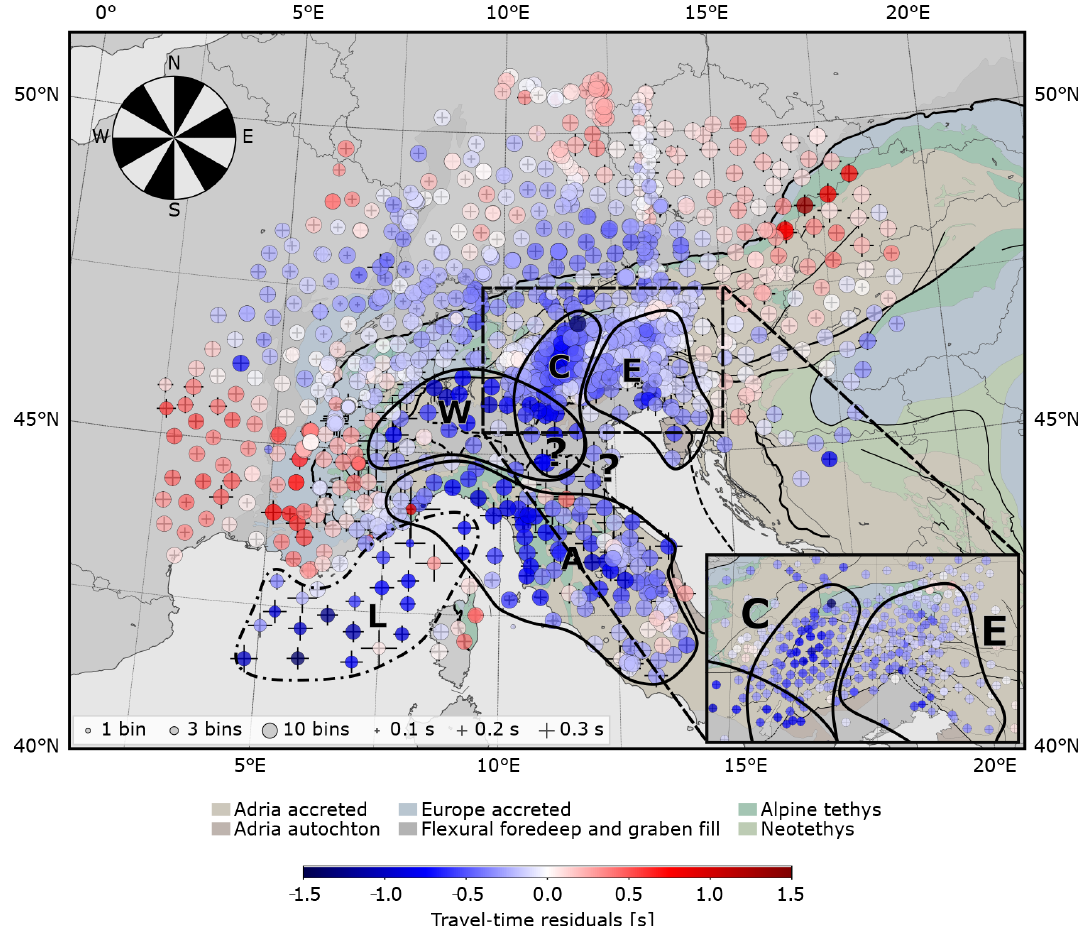
Figure 10. Stacked travel-time differences for 370 events of the high-frequency dataset db 0 . 5 corrected for crustal influences. Circle sizes correlate with number of back-azimuth bins for each station (maximum = 12). Blue colours point to subsurface structures with v p values higher than average, red colours to structures with v p values lower than average. Travel times are binned calculating the mean travel time for all events within 30 ◦ bins to balance out directional influences. Standard deviation of the azimuthal influence on each station is marked by crosses; e.g. small crosses mark stations residuals mostly independent of variations in back-azimuth. A travel-time correction is applied for the station elevation using a constant near-surface velocity estimate of 5.5kms − 1 . High-velocity anomalies are contoured as follows: W – western Alps, C – central Alps, E – eastern Alps, A – Apennines, L – Ligurian Basin. Tectonic map of the Alpine chains compiled by Handy (2021). Tectonic units and major lineaments simplified from Bigi et al. (1990), Schmid et al. (2004, 2008), Froitzheim et al. (1996), Handy et al. (2010) and Bousquet et al.